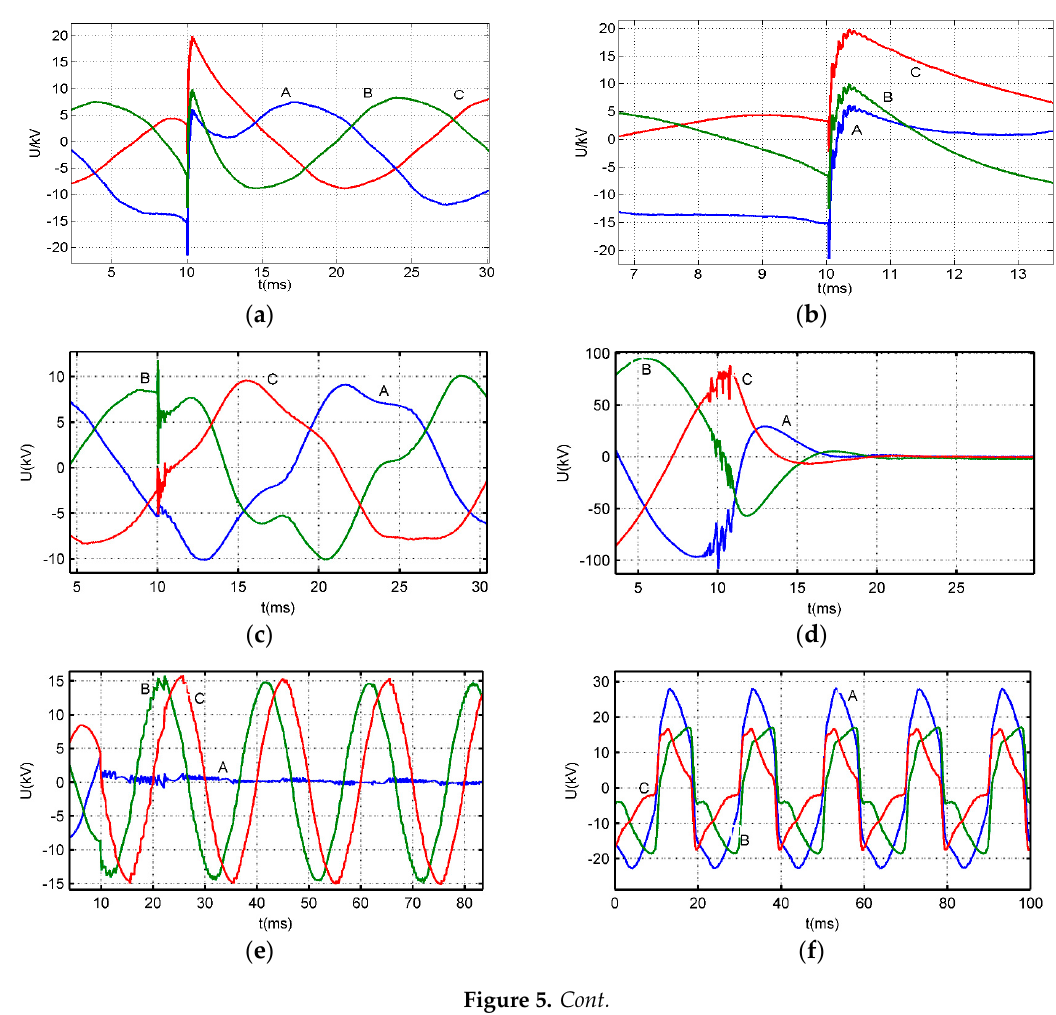
Figure 4. The principle of variable frequency sampling speed data acquisition card.